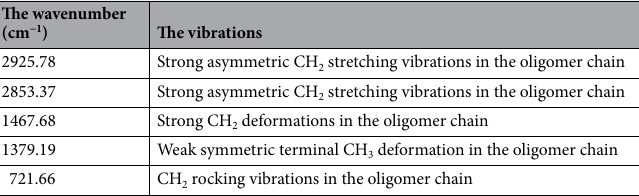
The wavenumber (cm −1 )